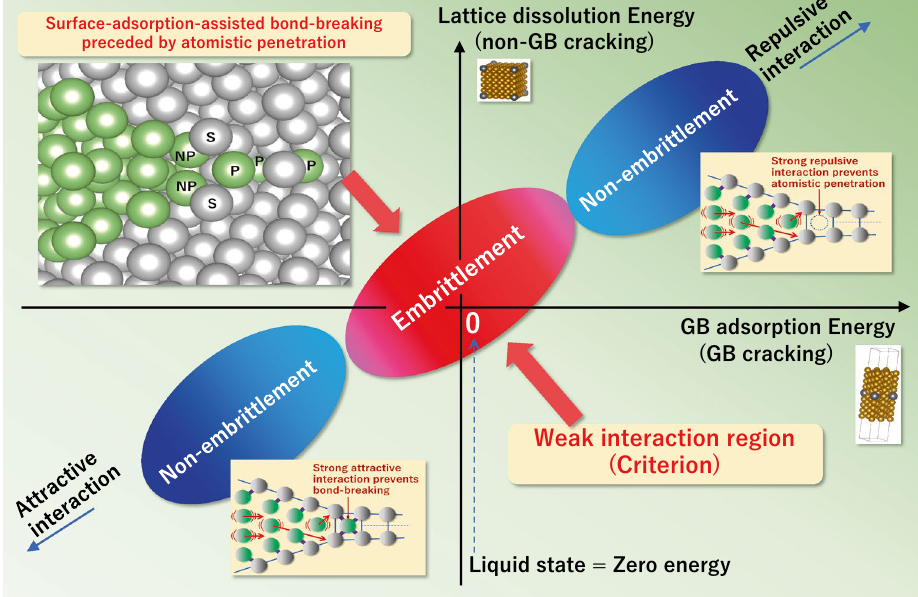
Figure 3. Schematic illustration of the criterion for the specificity of LME. P: a penetrated liquid metal atom into solid, NP: a not-yet-penetrated liquid metal atom that adsorbed on a solid metal atom, S: a solid metal atom with broken solid–solid interatomic bond by the adsorption of liquid metal atom. The solid–liquid couples that satisfy the weak interaction (near-zero energy) criterion show embrittlement. The atomistic embrittling (bond-breaking) process is schematically shown in Fig. 2 (Supplementary Fig. S9b), where the weak interaction criterion is satisfied. Contrarily, the atomistic penetration or the subsequent bond-breaking is suppressed in the cases of non-embrittlement (Supplementary Fig.